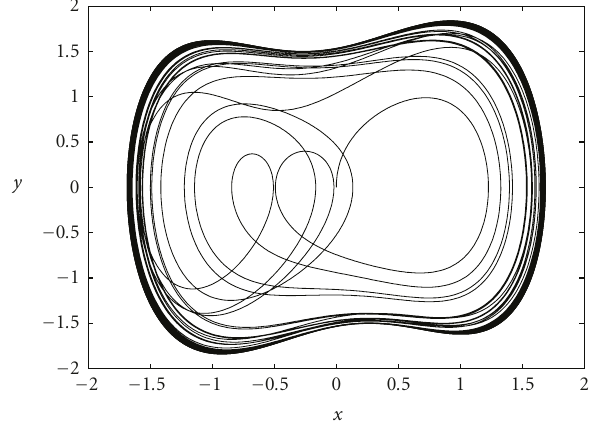
Figure 3: Phase plane at critic state.